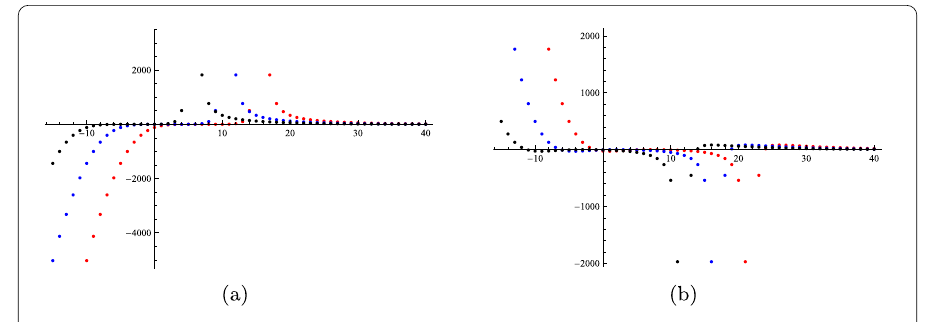
Figure 3 One-soliton solutions of Q2 without backgrounds. ( a ) Solution (3.15), ( b ) solution (3.17); where a = –0.5, b = –0.5, s = 4.5, ρ 0,0 = 0.5, c 0 = 1, ζ 1 = ζ 3 = ζ 5 = 1, δ = –3, m ∈ [–15,40], waves in red, blue and black stand for n = –5,0,5,